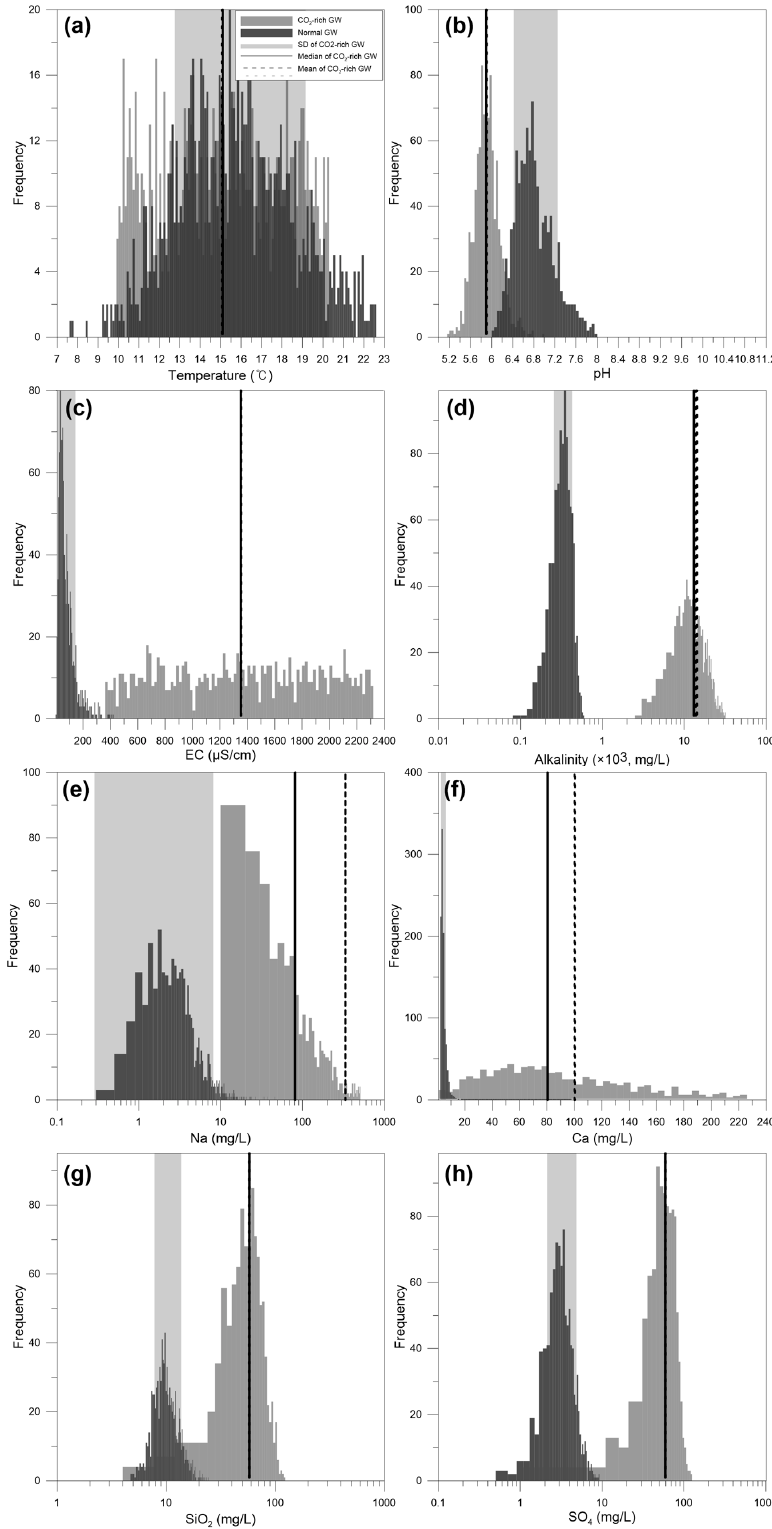
Figure 2. Probability density distributions of major parameters of CO 2 -rich (gray) and ordinary (dark gray) groundwaters in the Gangwon Province. ( a ) Temperature, ( b ) pH, ( c ), EC, ( d ) Alkalinity, ( e ) Na, ( f ) Ca, ( g ) SiO 2 , ( h ) SO 4 .